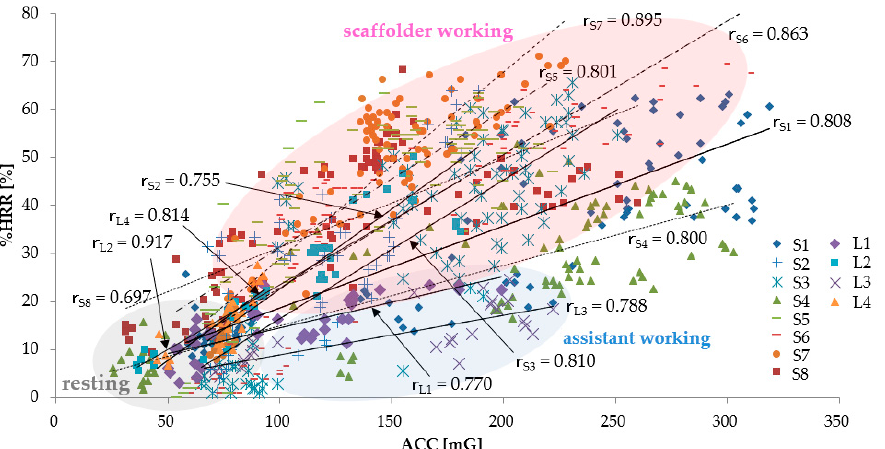
Figure 2. Relationship between acceleration (ACC) and heart rate reserve (%HRR) (Scaffolder S1–S8 ,